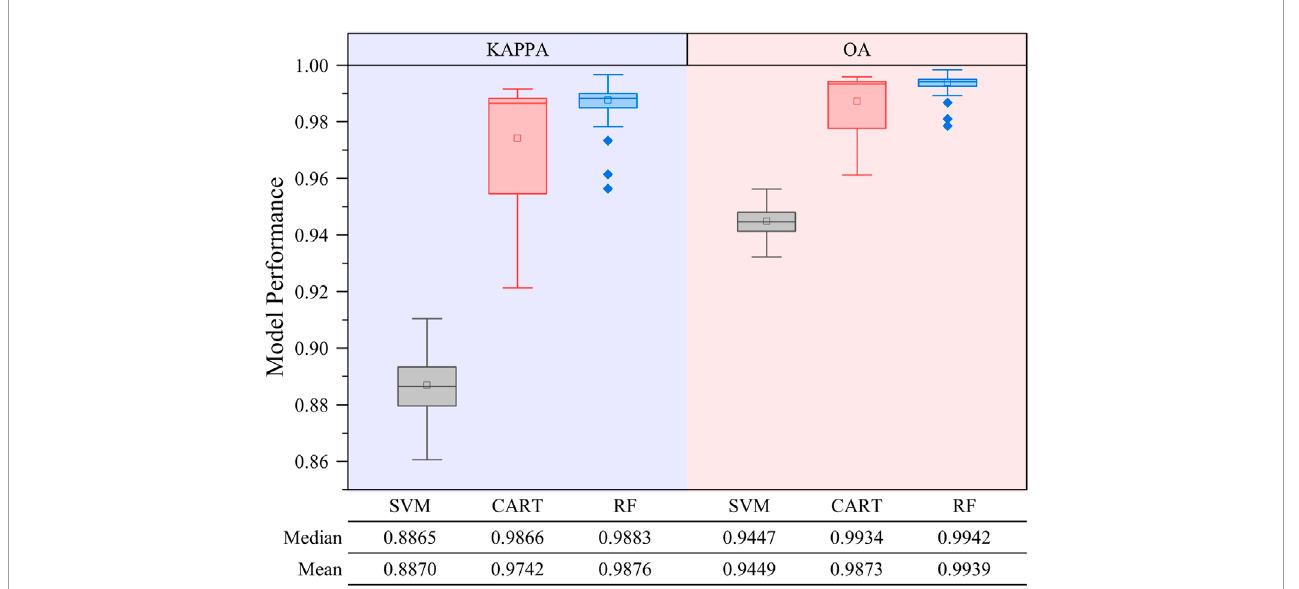
FIGURE 4 Evaluation metrics regarding the performances of different